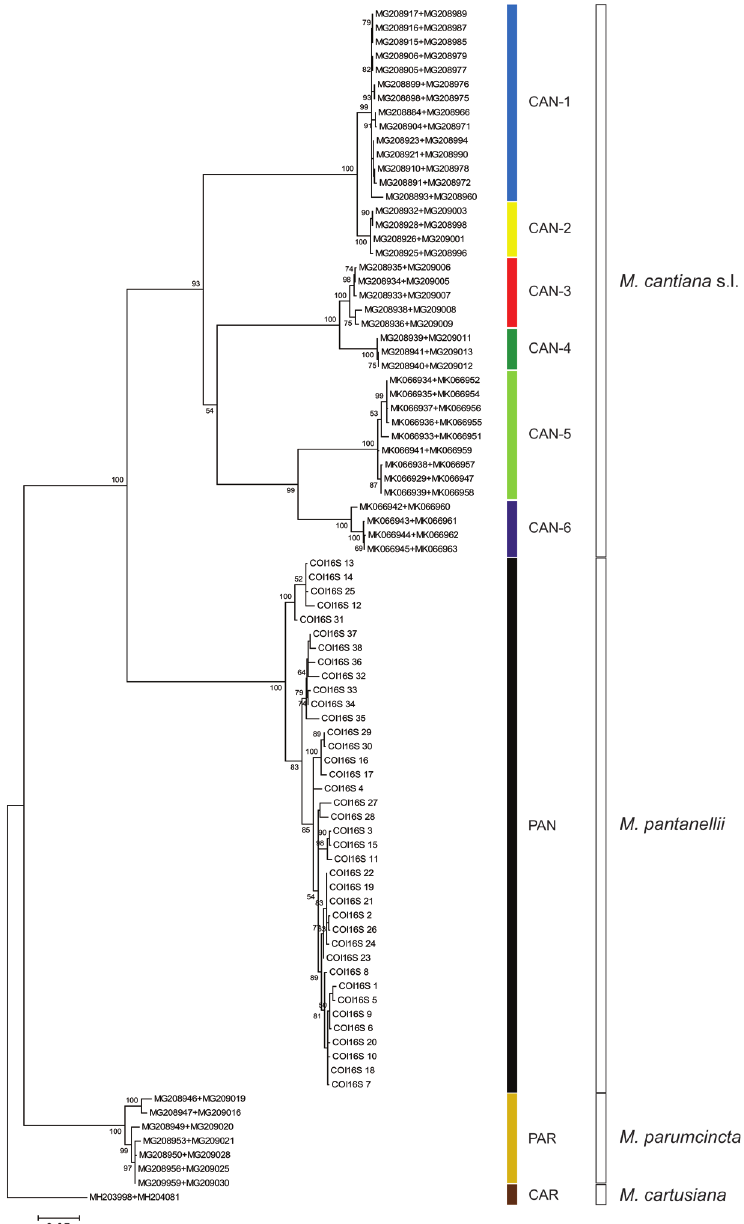
Figure 2. Maximum Likelihood (ML) tree of concatenated COI and 16S rDNA haplotypes of Monacha pantanellii (see Table 4). New COI and 16S rDNA sequences of M. pantanellii (Table 1) were compared with COI and 16S rDNA sequences of M. cantiana s. l. and M. parumcincta obtained from GenBank (Tables 2, 4). Numbers next to branches indicate bootstrap support above 50% calculated on 1000 rep- licates (Felsenstein 1985). The tree was rooted with M. cartusiana concatenated sequences obtained from GenBank (Table